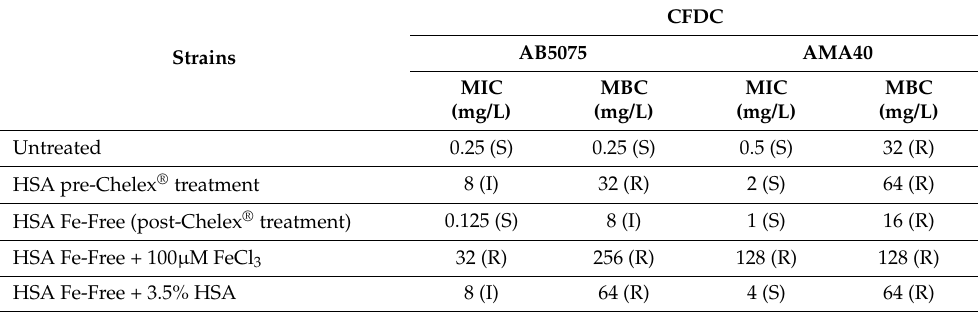
Table 2. The minimal inhibitory concentrations (MICs) and minimal bactericidal concentrations (MBCs) of CFDC for the CRAB AB5075 and AMA40 strains calculated via microdilution on iron- depleted CAMHB and the different conditions